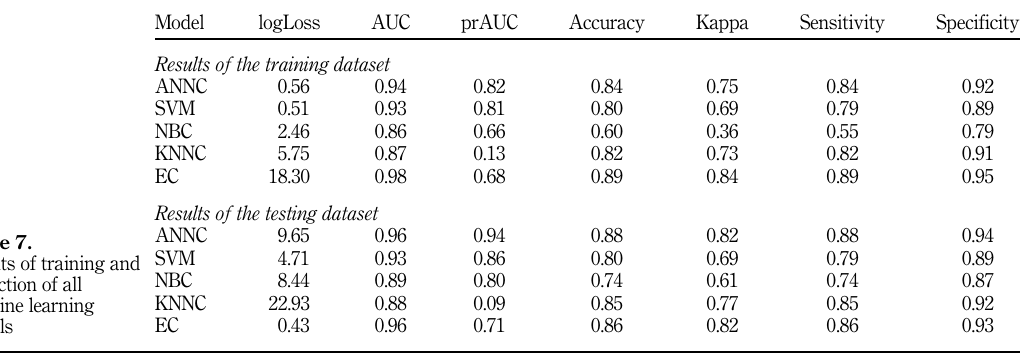
Table 7. Results of training and prediction of all machine learning